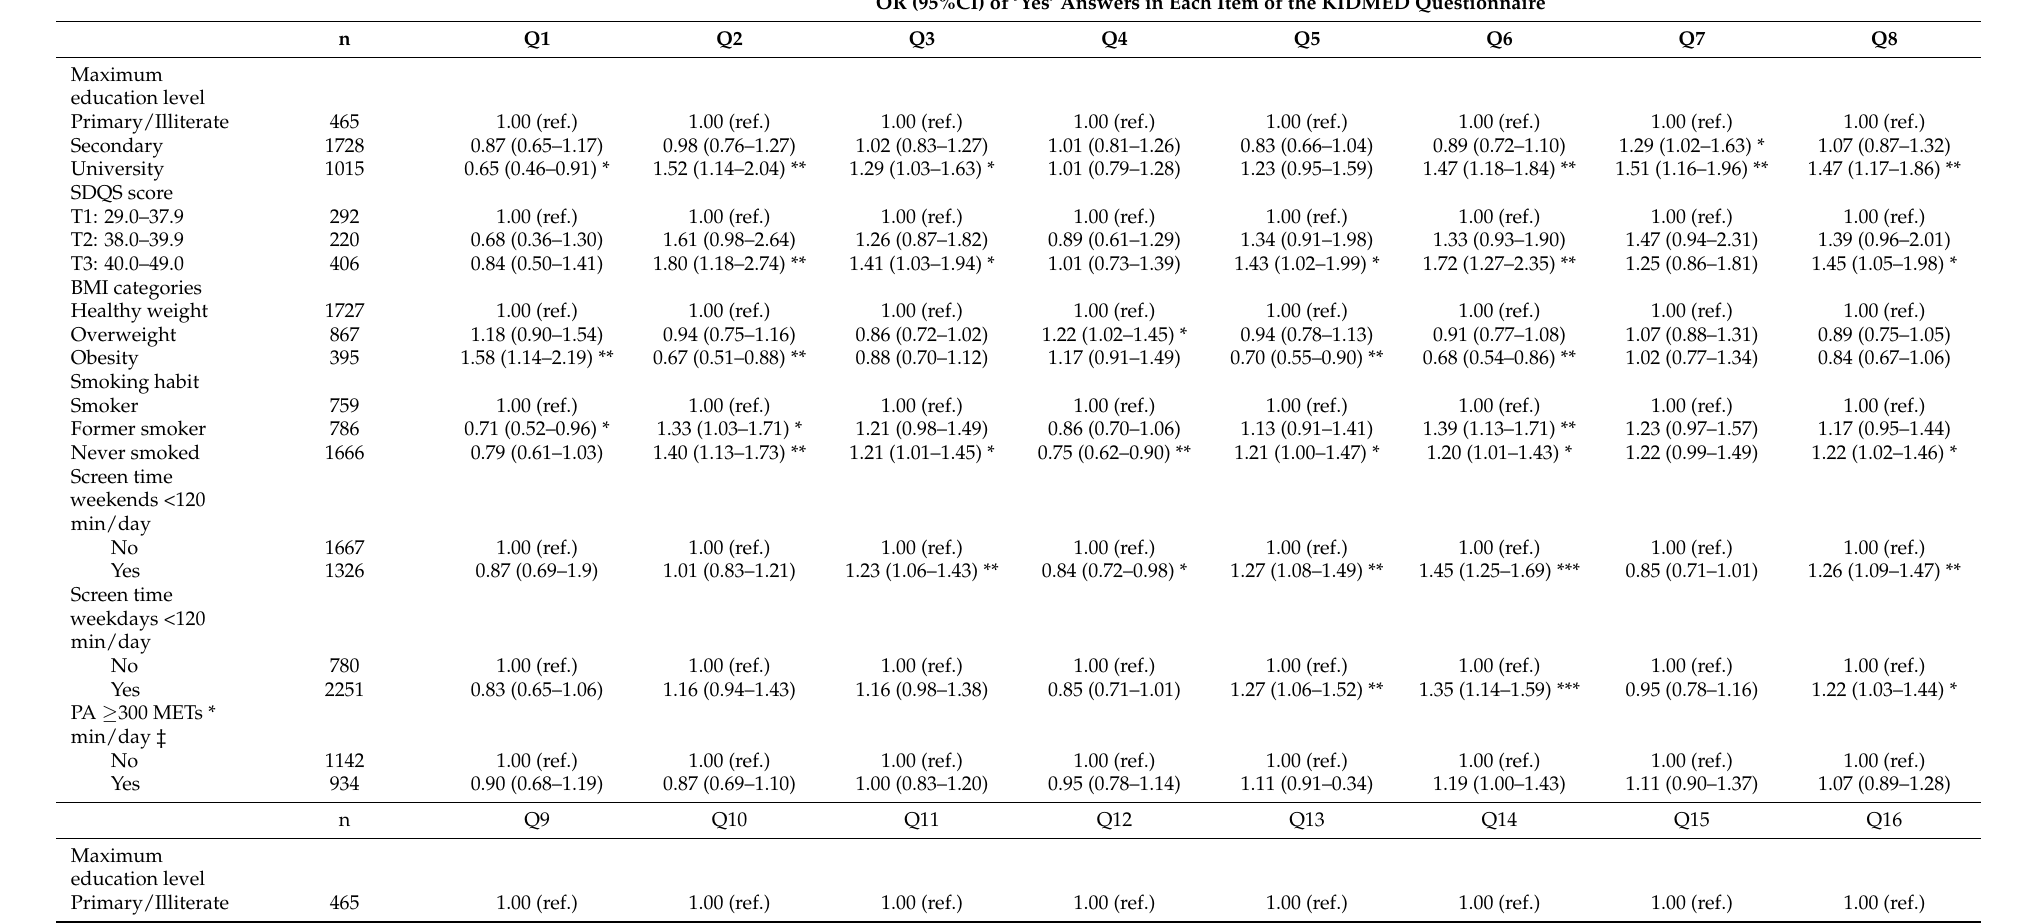
Table 6. Odds ratios (and 95% confidence intervals) from logistic regression showing the association of child/adolescent characteristics with child/adolescent ‘yes’ answers in the KIDMED